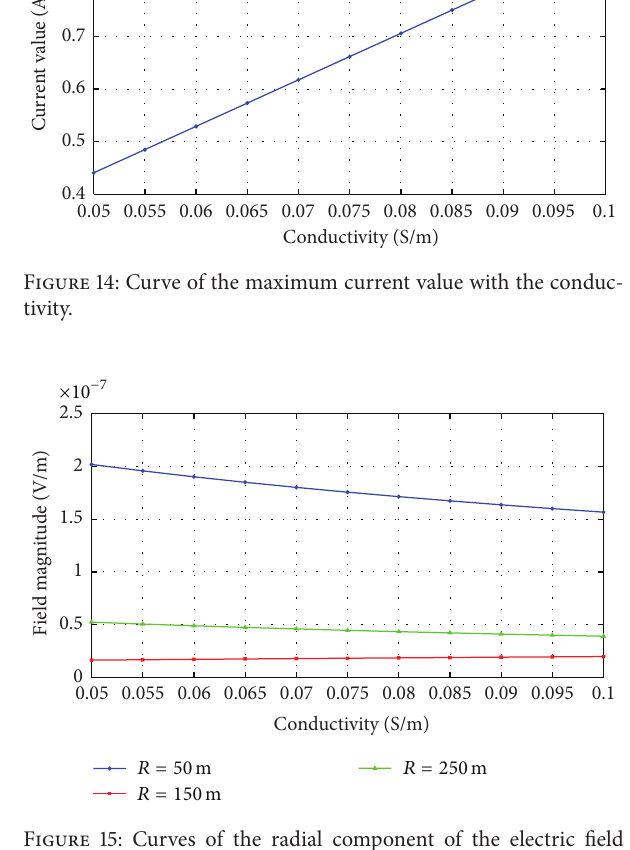
Figure 15: Curves of the radial component of the electric field magnitude with the conductivity.